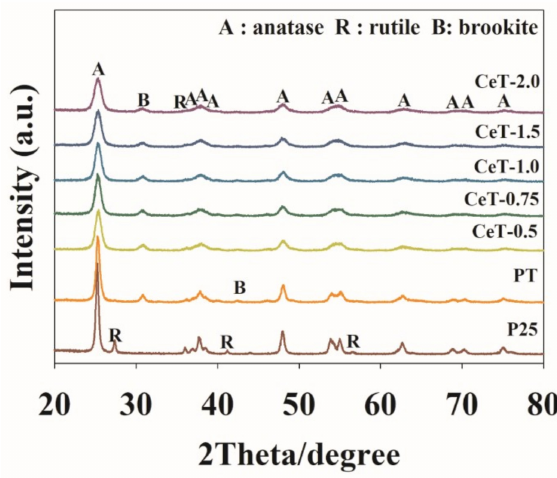
Figure 2. XRD spectra of Degussa P25 TiO 2 (P25), pure TiO 2 (PT), and Ce-doped TiO 2 catalysts with di ff erent Ce contents (CeT-0.5, 0.75, 1.0, 1.5, and 2.0).